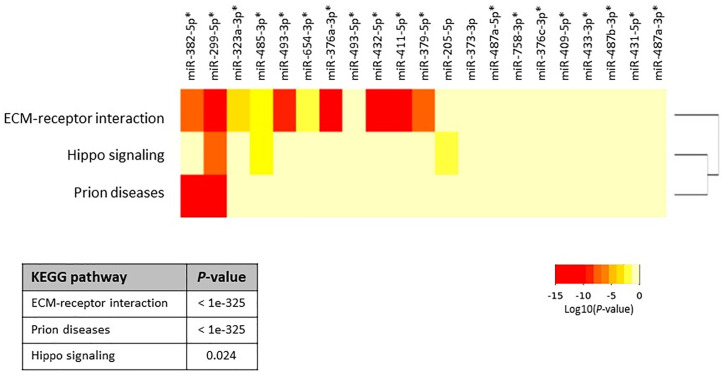
Heatmap of upregulated miRNAs versus significantly enriched functional pathways. In the heatmap, darker colors represent higher statistical significance of the Log10(P-value) as indicated by the color key at the bottom. Pathways showing P-values < 0.05 were considered significantly enriched between the groups under comparison. The attached dendrogram on the Y-axis depicts hierarchical clustering results for the pathways. Asterisks show the miRNAs that are located within the DLK1-DIO3 region on chromosome 14q32.2. The figure was developed from the output of Diana mirPath v.3.